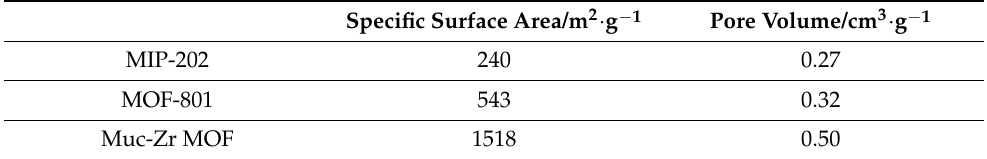
Figure 6. ( Left ) MIP-202, ( middle ) MOF-801 and ( right ) Muc-Zr MOF structures with the specific surface area accessible to N2 (blue and grey). Table 2. Theoretical values for specific surface area for N 2 and pore volume for the investigated solids.